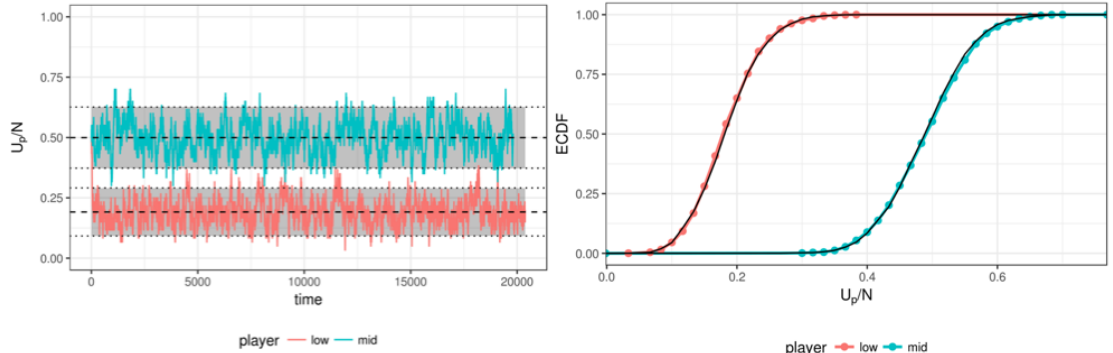
Figure 4. The left panel depict the estimates of two players (one with a low and one with medium true value throughout the simulation, with the grey bars indicating the 95% CI. The right panel shows close correspondence of the cumulative density function based on the estimates (coloured dots) and based on the true values (black line).